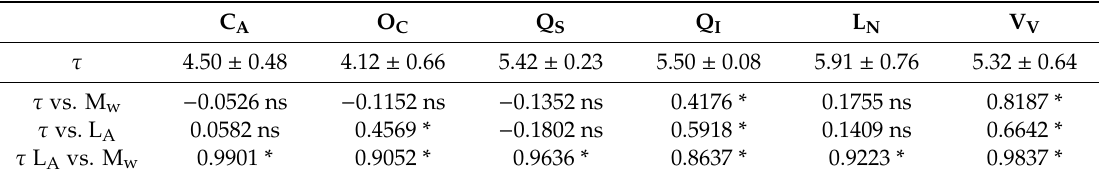
Table 2. Optical depth ( τ ; average ± SD) and the adjusted R 2 values of the linear regression models of each species (ns = not significant; * = significantly di ff erent from zero at p ≤